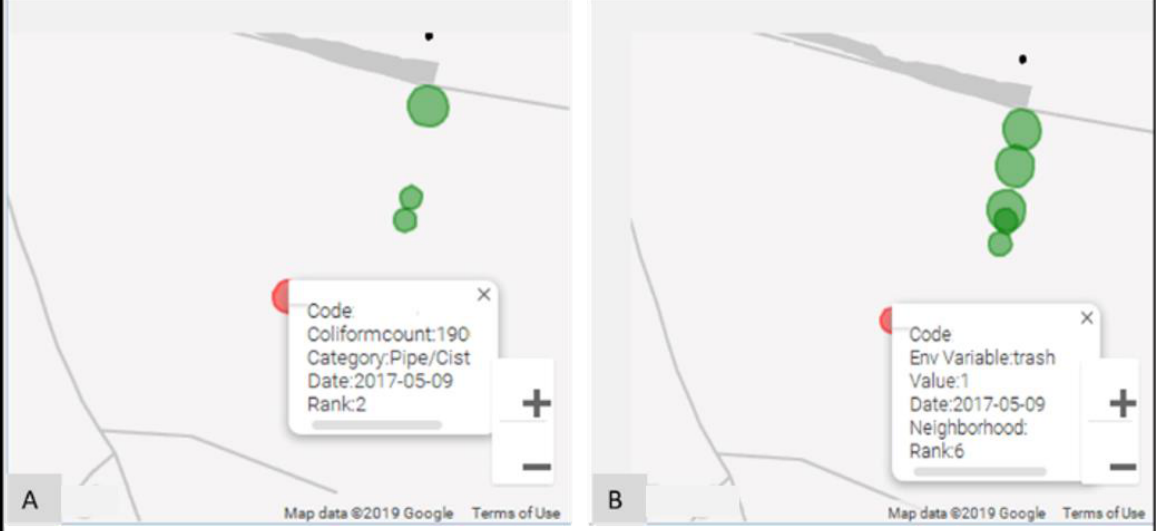
Figure 6. Proportional symbol map to display the spatial distribution of: ( A ) epidemiological records, ( B ) environmental records.